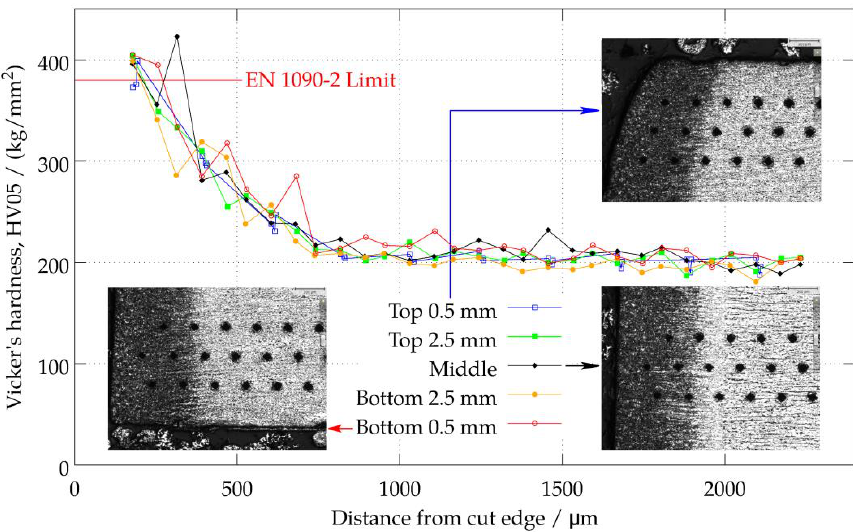
Figure 6. Hardness profiles against the distance to the cut edge. Each color corresponds to a region of the sample, blue corresponding to the one closest to the plasma nozzle and red to the region further from the plasma nozzle. Images included in the graph show the microstructure and indentations distribution used to make the plot in three regions ( top , middle and bottom